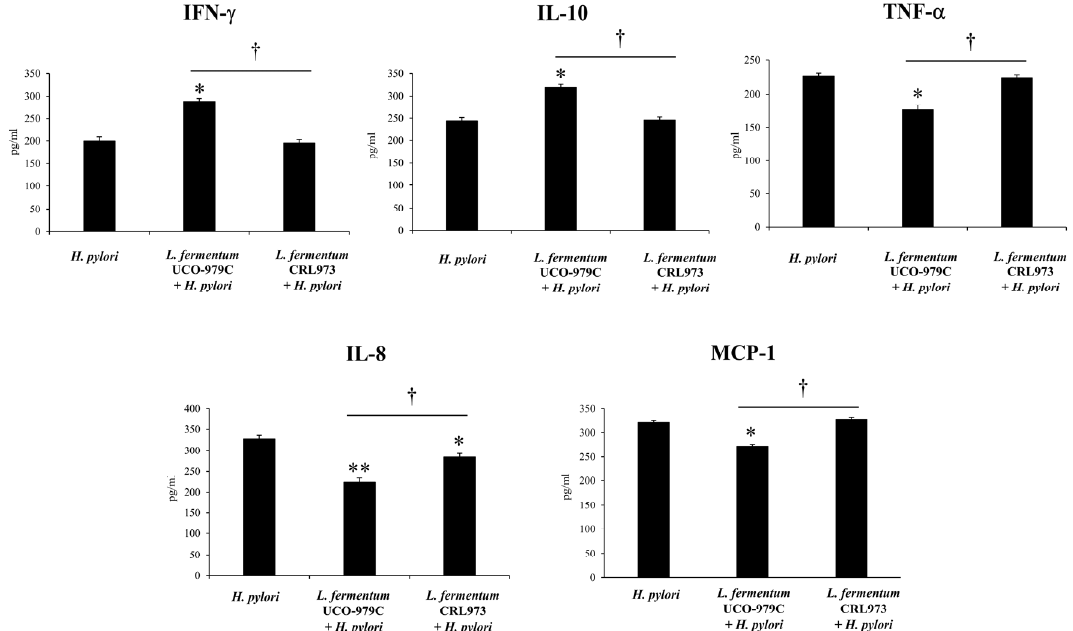
Figure 3. Effect of viable L. fermentum UCO-979C or L. fermentum CRL973 on gastric cytokines and chemokines in H. pylori SS1- infected mice. Effect of viable L. fermentum UCO-979C or L. fermentum CRL973 on gastric cytokines and chemokines in adult immunocompetent mice infected with H. pylori SS1. L. fermentum UCO-979C or L. fermentum CRL973 were administered to different groups of mice for two consecutive days at a dose of 10 8 CFU/mouse/day, then mice were challenged with H. pylori SS1. Two days post infection, gastric concentrations of IFN- γ , IL-10, TNF- α , IL-8 and MCP-1 (pg/mL) were determined. Mice infected with H. pylori were used as controls. Results are expressed as mean ± SD. Significant differences when compared to the control group: * ( p < 0.05),** ( p < 0.01). Significant differences when compared to the indicated group: † ( p < 0.05).